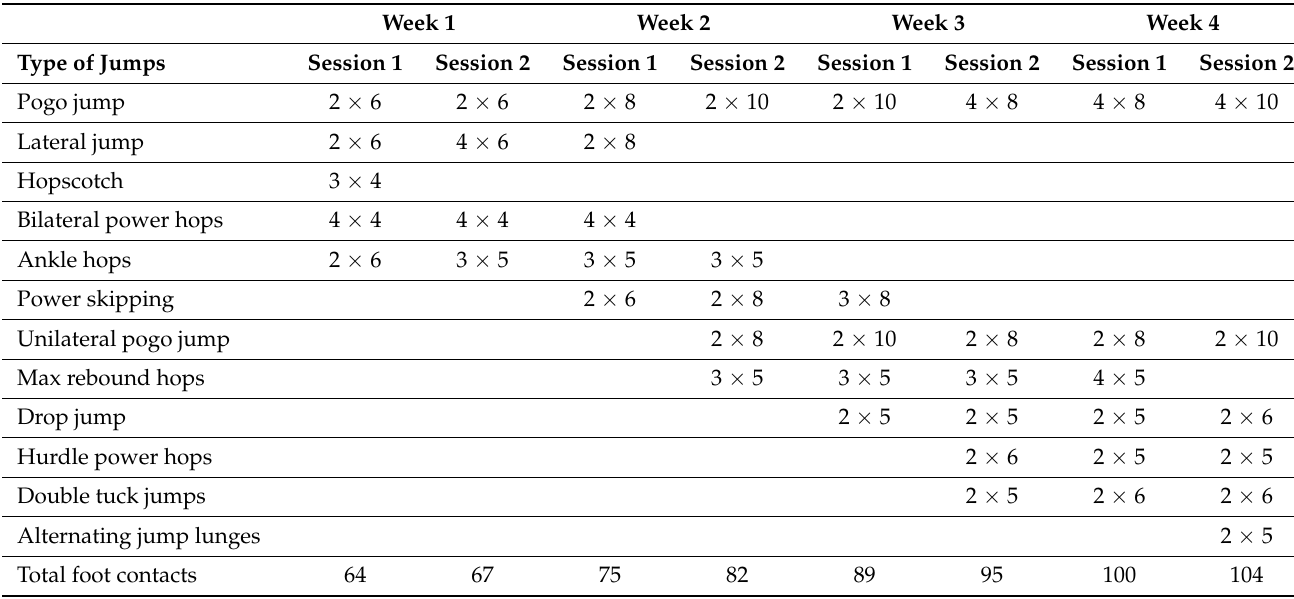
Table 2. Description of the plyometric training